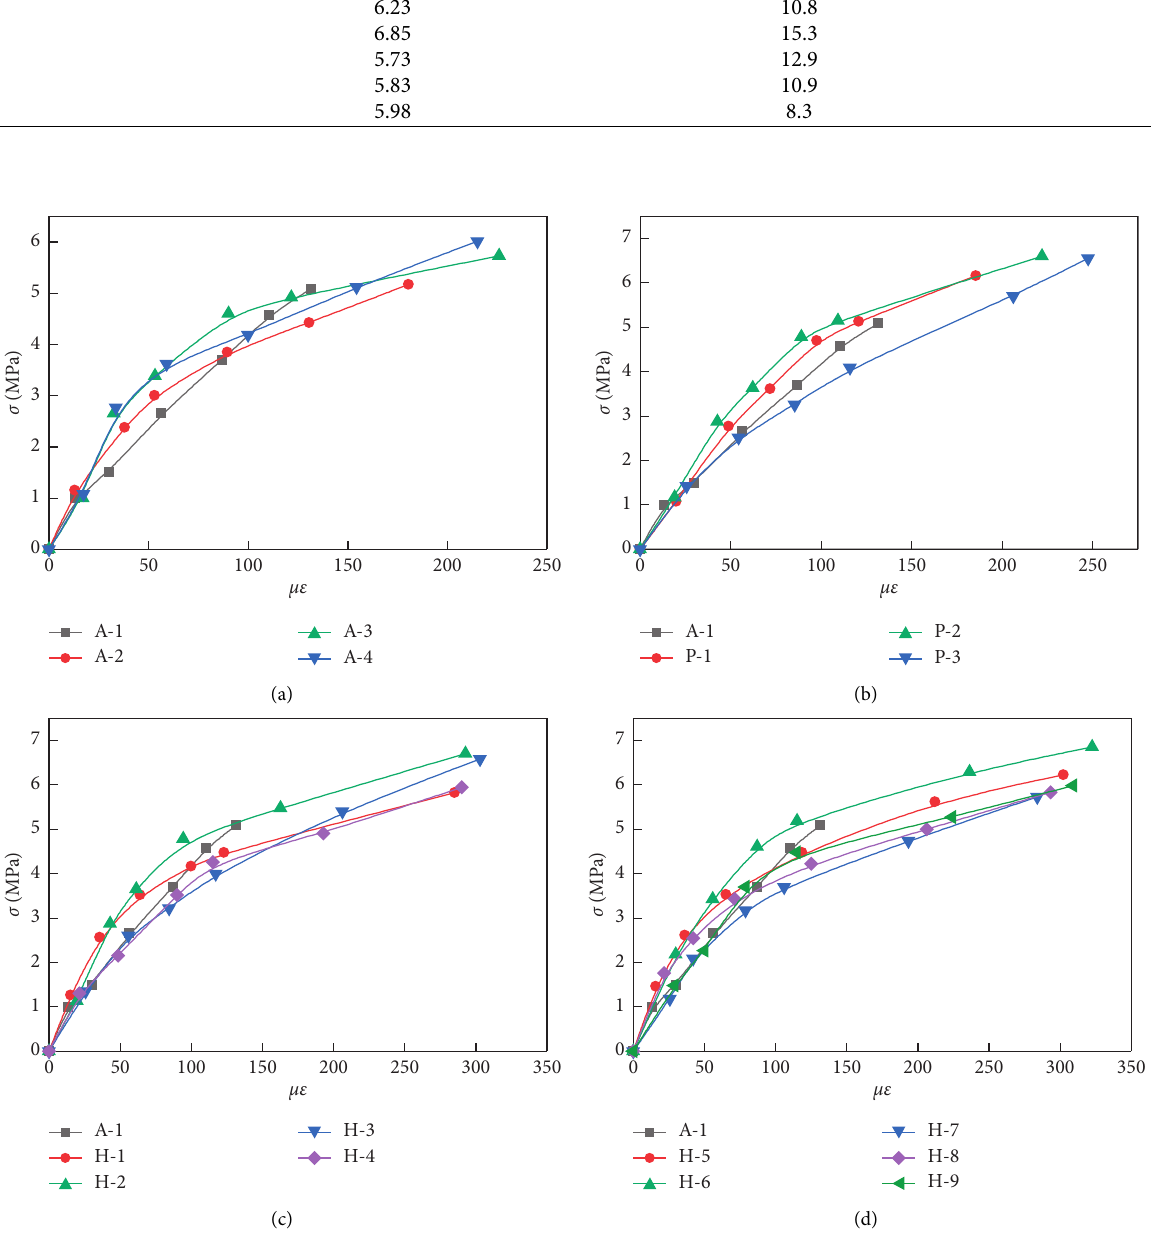
Figure 8: Comparison of stress-strain curves of concrete with different volume rates of fibers (before the peak value of flexural capacity). (a) PC and BFRC, (b) PC and PFRC, (c) PC and H-1 ∼ H-4, (d) PC and H-5 ∼